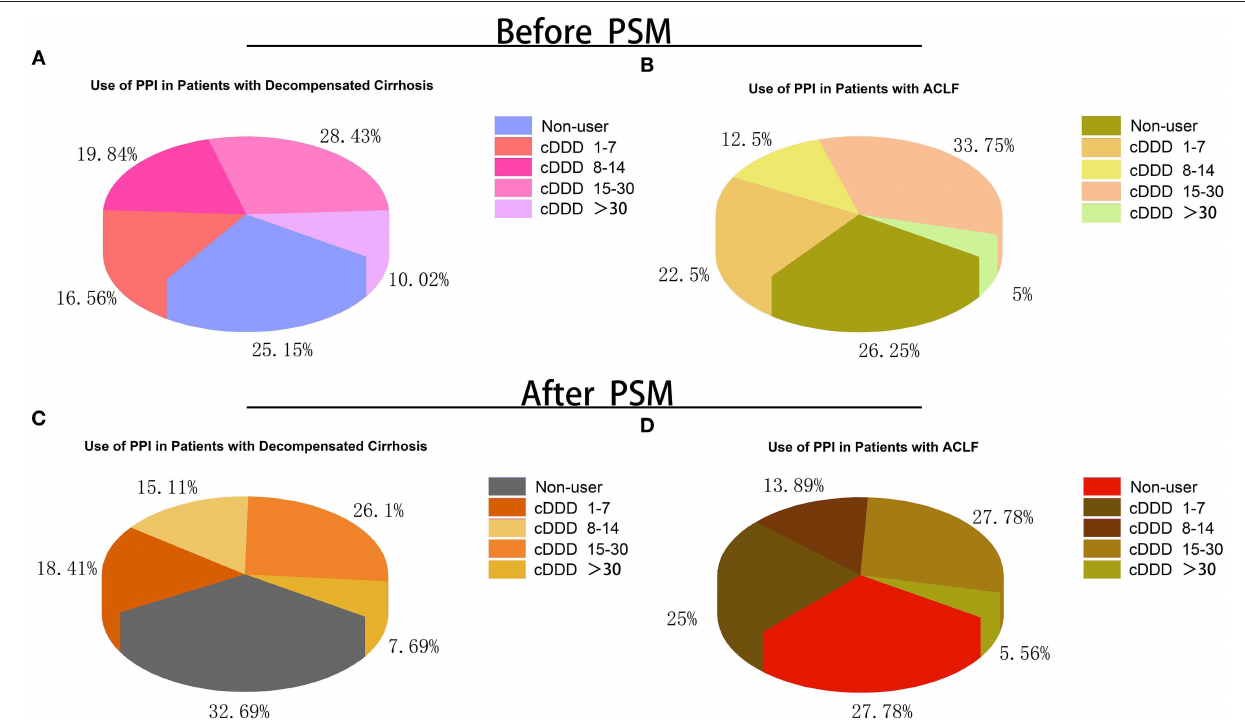
Frontiers in Medicine |